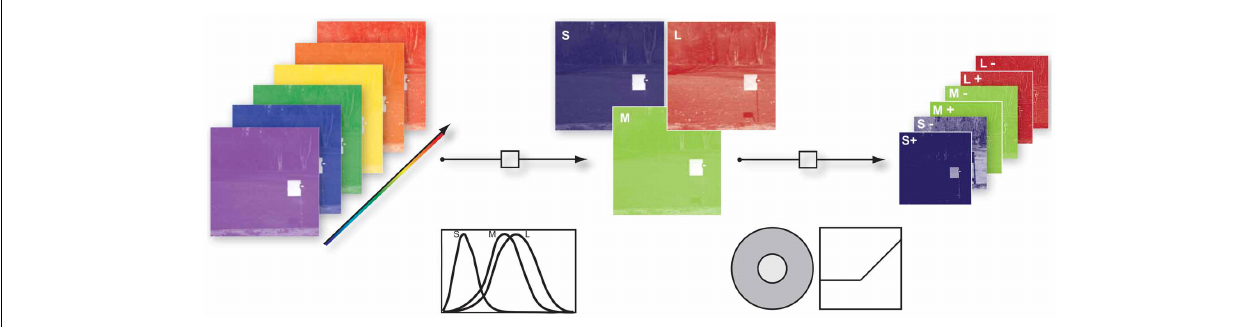
FIGURE 1 | Illustration of the image filtering process. (1) Illustration of hyper-spectral image. Each image consisted of 31 image planes corresponding to radiance within wavebands between 400nm and 700nm (2) S-, M-, and L- photoreceptor cone activation were derived via their specific